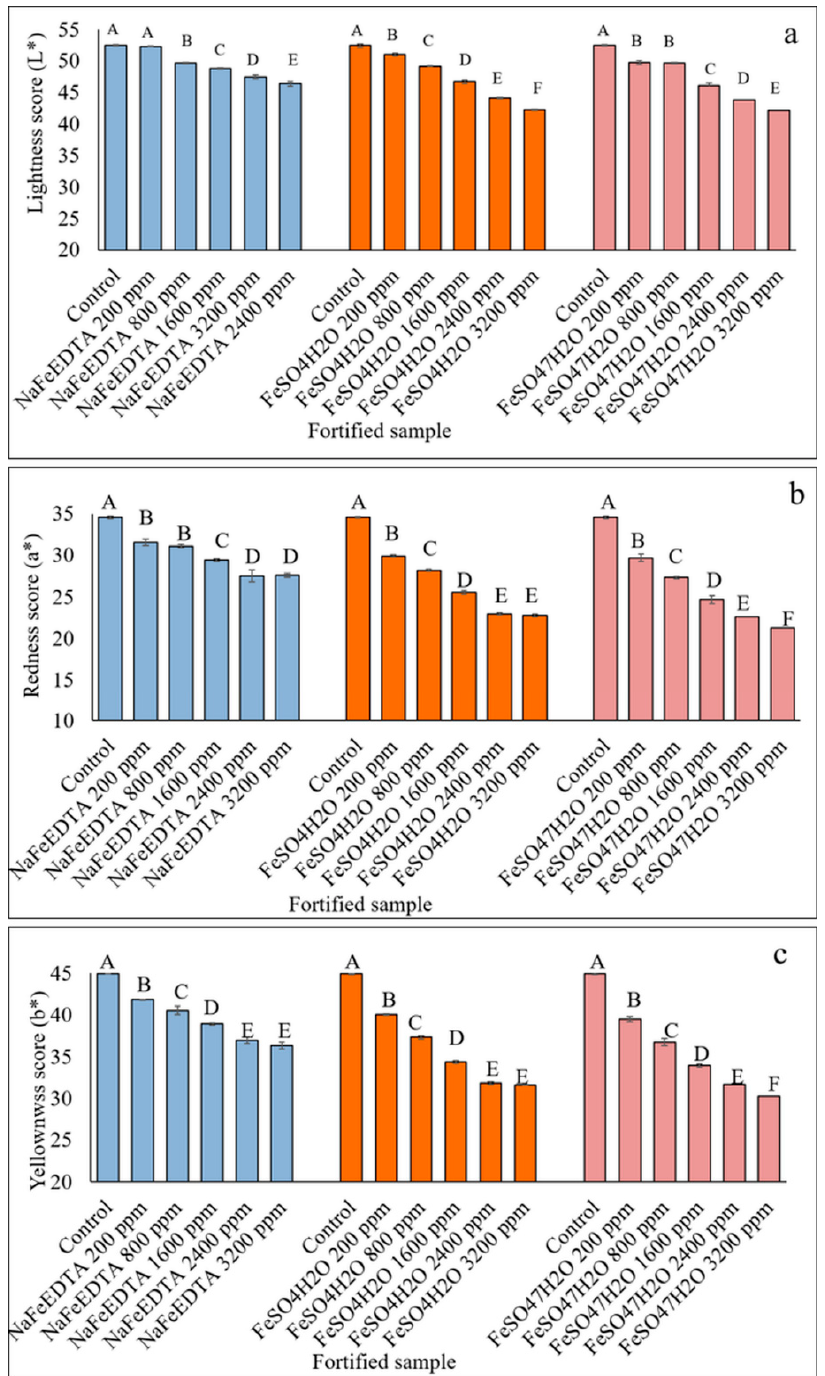
Figure 6. Effect of increasing Fe concentration on lightness (L*), redness (a*) and yellowness scores (b*) of lentil dal samples fortified with FeSO 4 ·7H 2 O, NaFeEDTA and FeSO 4 ·H 2 O at five different concentrations ranging from 200–3200 ppm. Different letters within each figure represent significant differences ( p < 0.05).